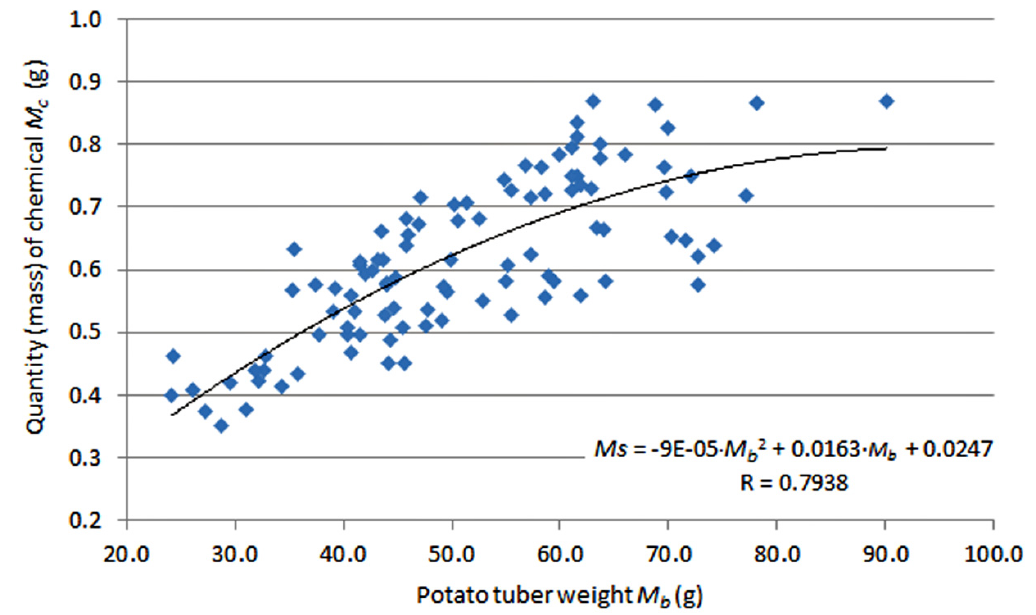
Figure 3. The dependence between the amount of the agent applied to the surface of seed potato tubers and the tuber weight.